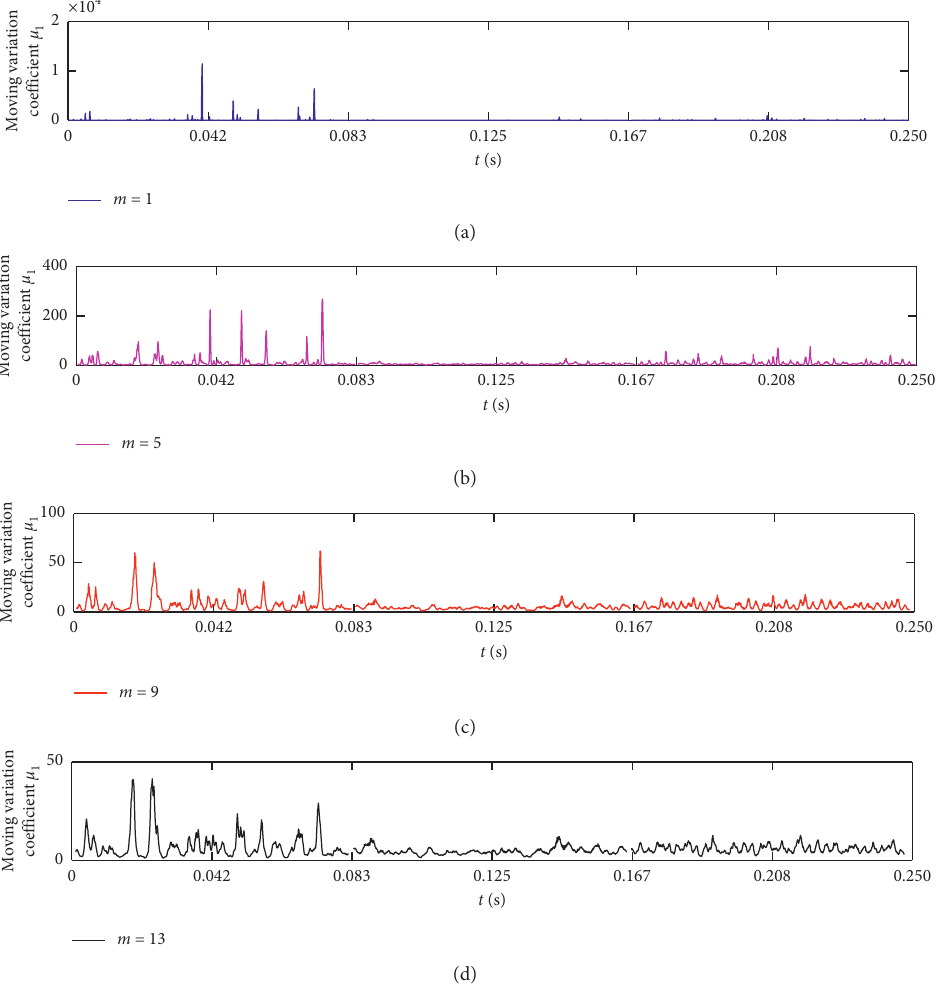
Figure 9: Calculation results of mechanical fault signals under different window lengths.